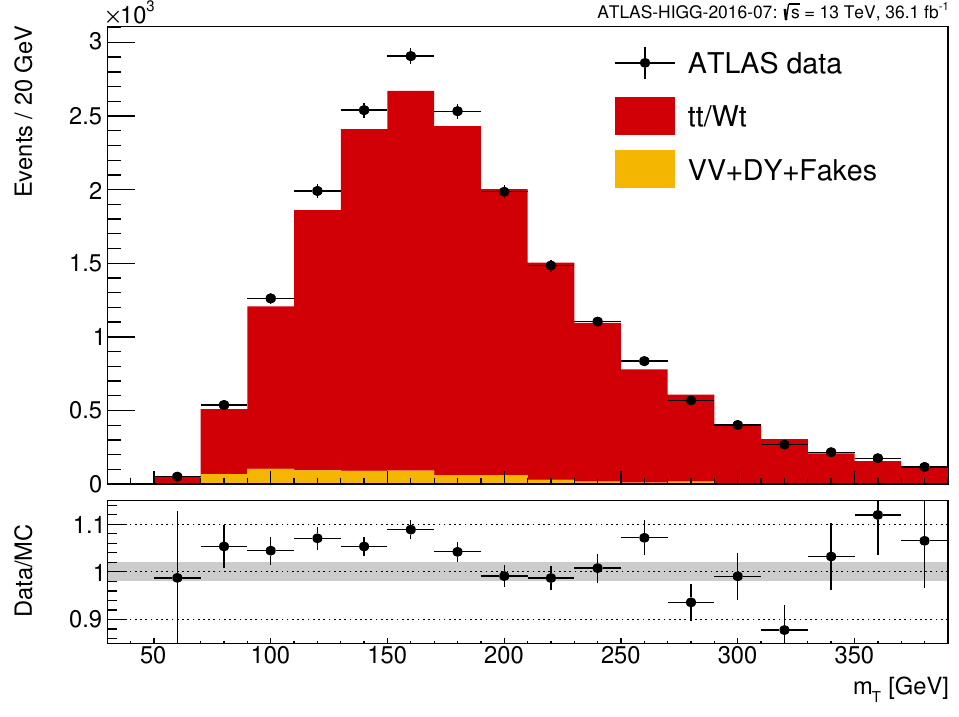
Figure 4 . The transverse mass distribution in the ATLAS Run 2 h ! WW (cid:3) top CR, scaled such that the integral in data and the SM MC match in the region of m T > 200 GeV. An estimated (cid:13)at systematic uncertainty of 2% is drawn only as a